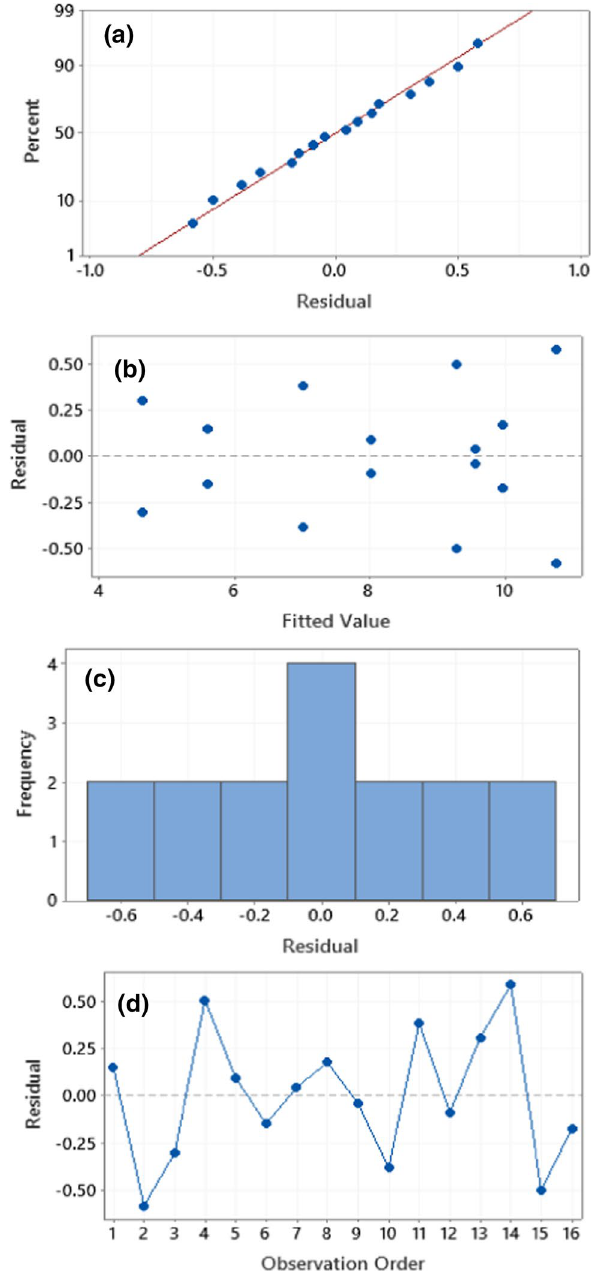
Fig. 7 Residual plots for water flux (L/m 2 ·h) using MgCl ing a normal probability plot, b residual versus fitted flux value, c fre- quency versus residual, and d residual versus observation